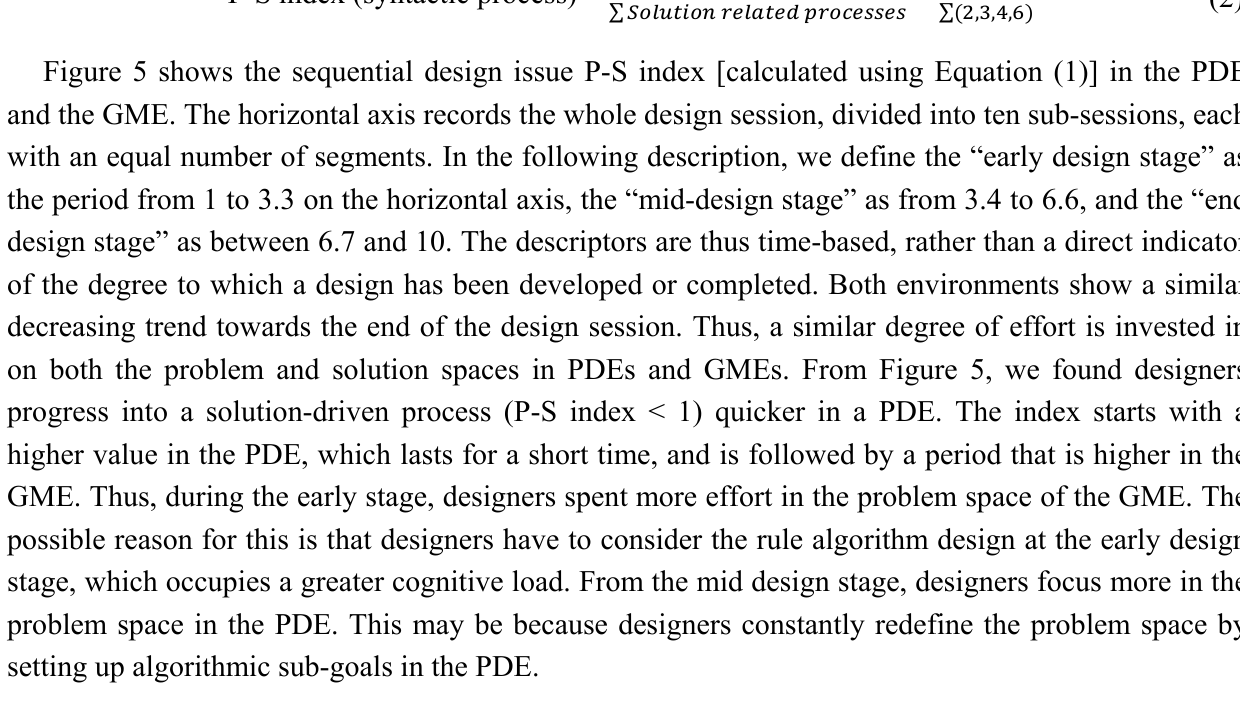
Figure 5. Sequential design issue P-S index in the PDE vs.